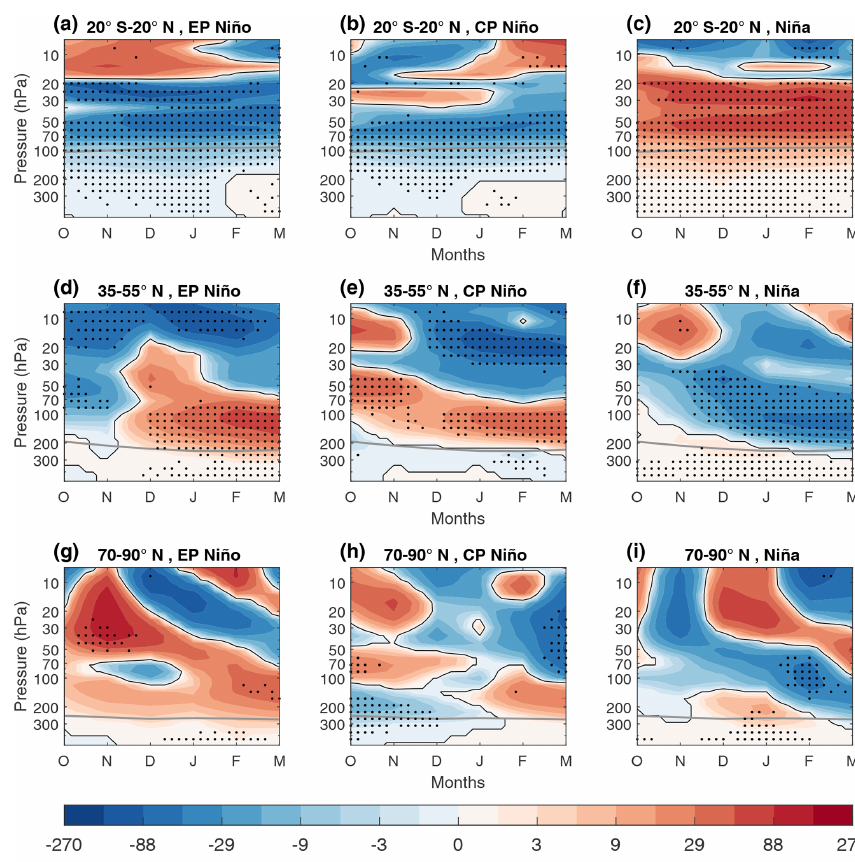
Figure 3. October–March composite evolution of anomalies in the ozone mixing ratio (ppbv) as a function of pressure (a–c) in the tropics (20 ◦ S–20 ◦ N), (d–f) at mid-latitudes (35–55 ◦ N) and (g–i) in the Arctic (70–90 ◦ N) for (from left to right) EP El Niño, CP El Niño and La Niña events. Black dots denote statistically significant anomalies at the 95% confidence level. The tropopause is indicated by the thick grey